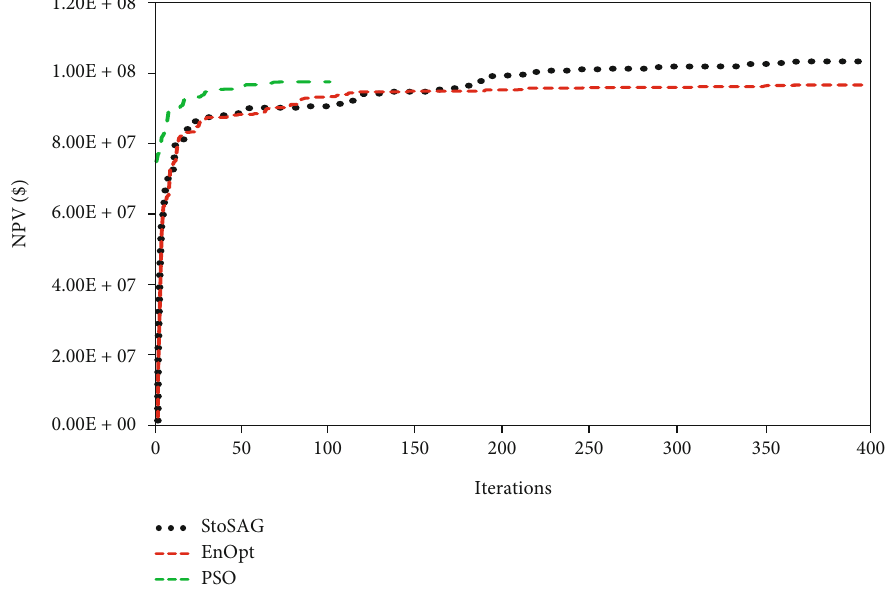
Figure 22: The NPV with respect to number of iterations based on di ff erent